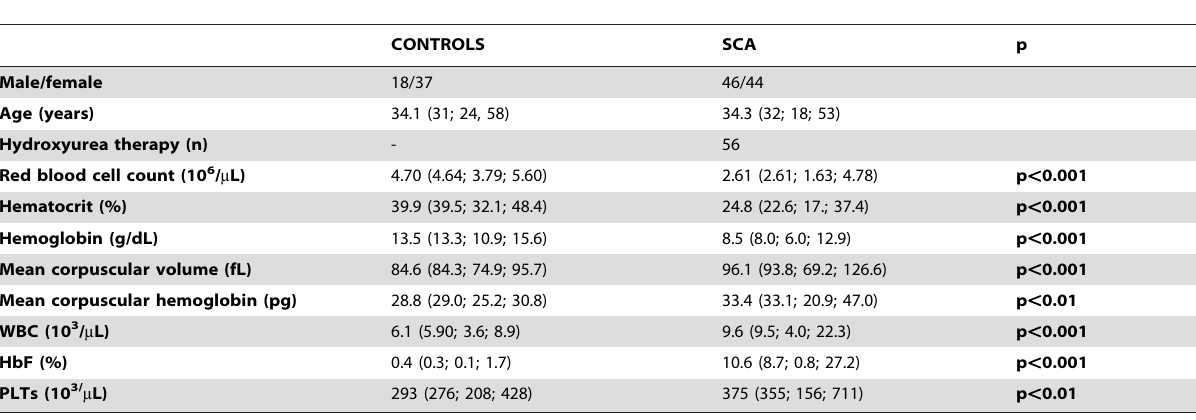
Table 1. Demographic, clinical and hematological details of all controls and patients participating in the study.